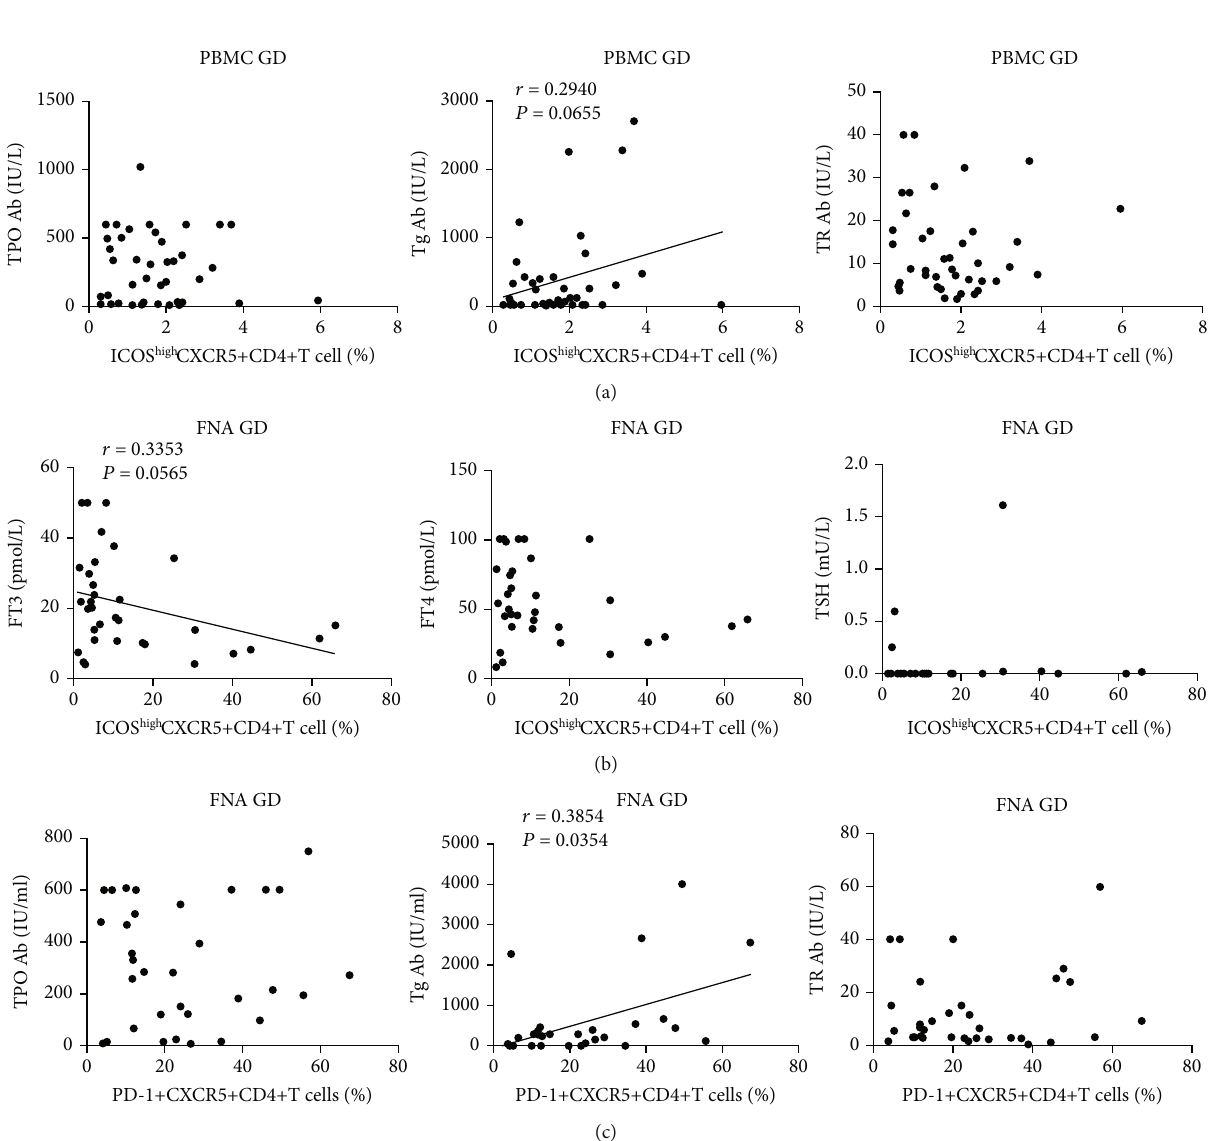
Figure 3: Correlations between Tfh cells and autoantibodies or thyroid function in GD patients. (a) Correlation between the frequency of circulating CD4 + CXCR5 + ICOS high Tfh cells and the levels of autoantibodies in GD patients. (b) Correlation between the frequency of intrathyroidal CD4 + CXCR5 + ICOS high Tfh cells and the levels of FT3, FT4, and TSH in GD patients. (c) Correlation between the frequency of intrathyroidal CD4 + CXCR5 + PD-1 + Tfh cells and the levels of autoantibodies in GD